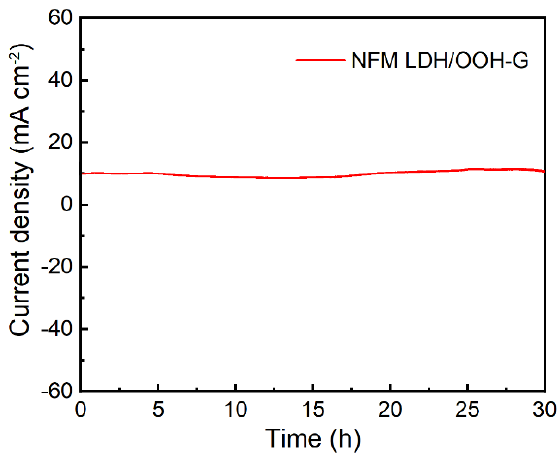
Figure 7. Chronopotentiometric curve of NFM LDH/OOH ‐ G at the current density of 10 mA cm − 2 in 1 M KOH solution. Table 1. Comparison of the characteristic OER performance between the prepared NFM LDH/OOH ‐ G and other reported non ‐ noble electrocatalysts in the literature.